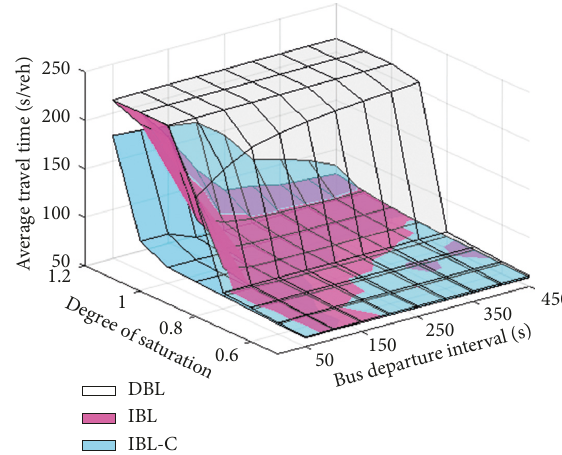
Figure 5: Regular vehicle average travel